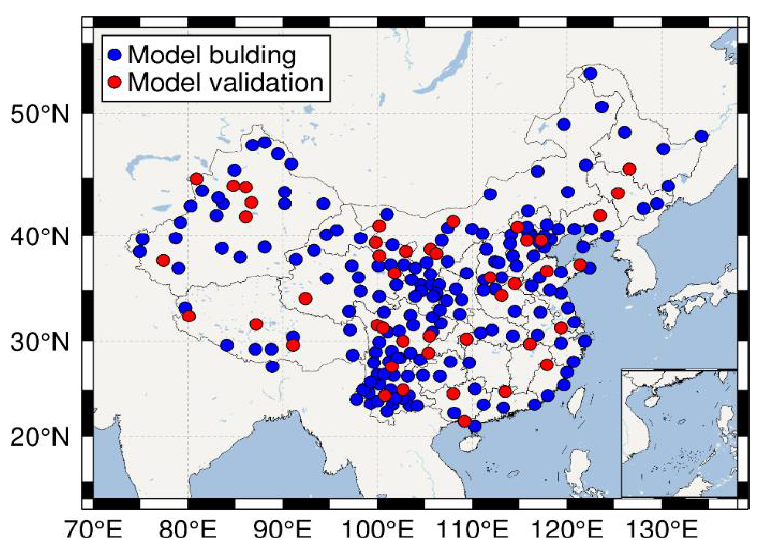
Figure 9. Distribution of modeling and verification stations. Blue spots were used for modeling, while red spots were used for external validation.